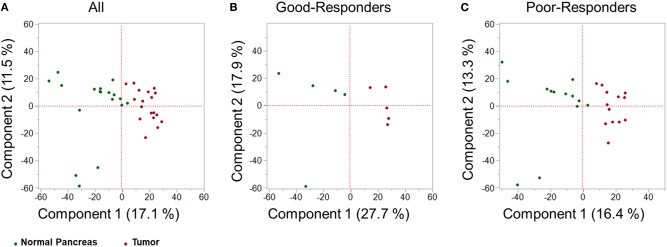
Multivariate proteomic analysis. Principal Component Analysis (PCA) score plot between first two principal components derived from the proteomic profile of tumor tissue (red) and adjacent healthy pancreas (green) in: (A) all PDAC patients; (B) good-NAC responders; and (C) poor-NAC responders.